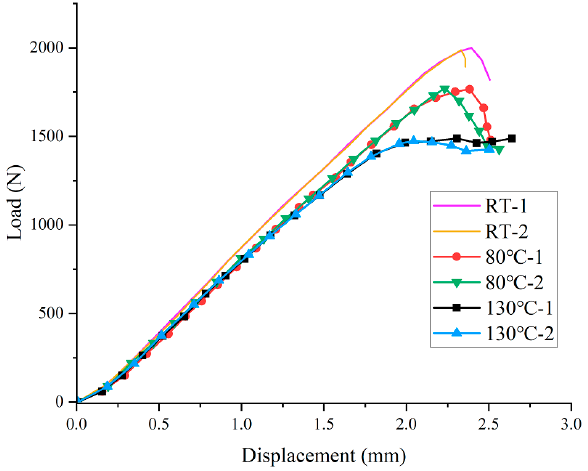
Figure 4. Load–displacement curves of ENF specimens evaluated at different temperatures.